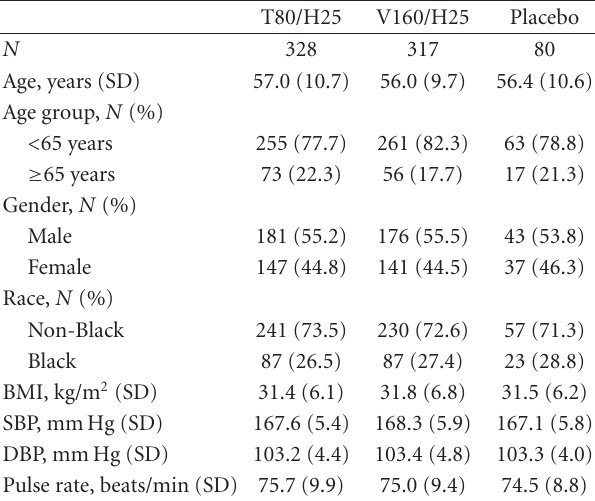
Table 1: Baseline